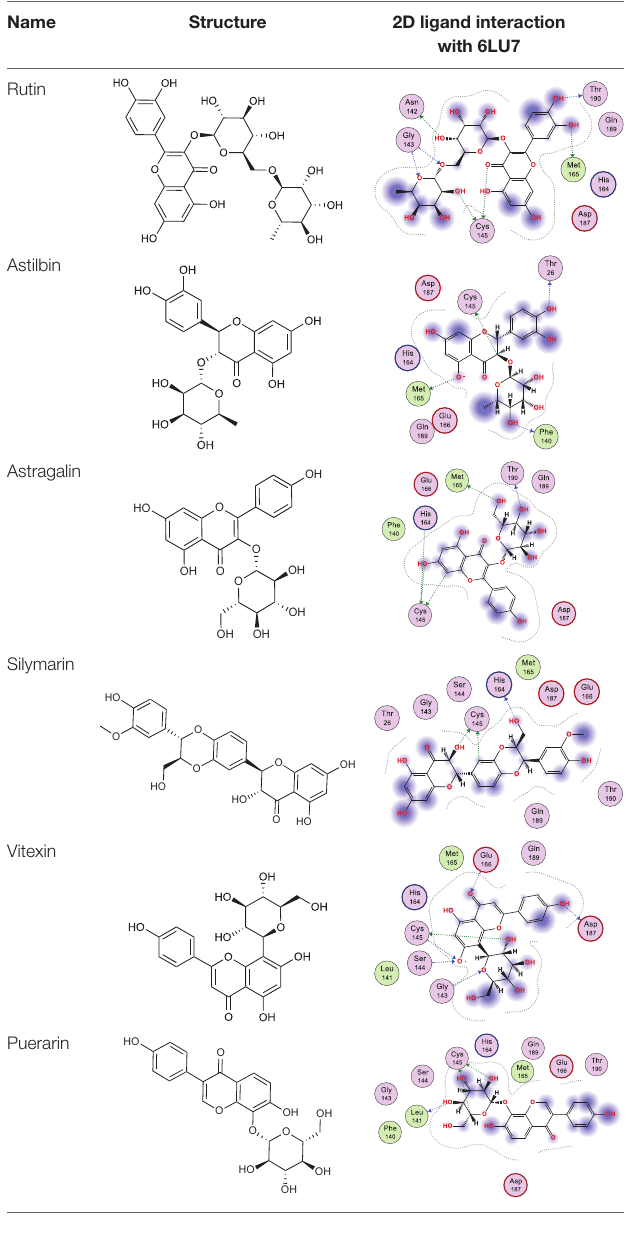
TABLE 1 | Six selected natural compounds according to the docked results and AUC.